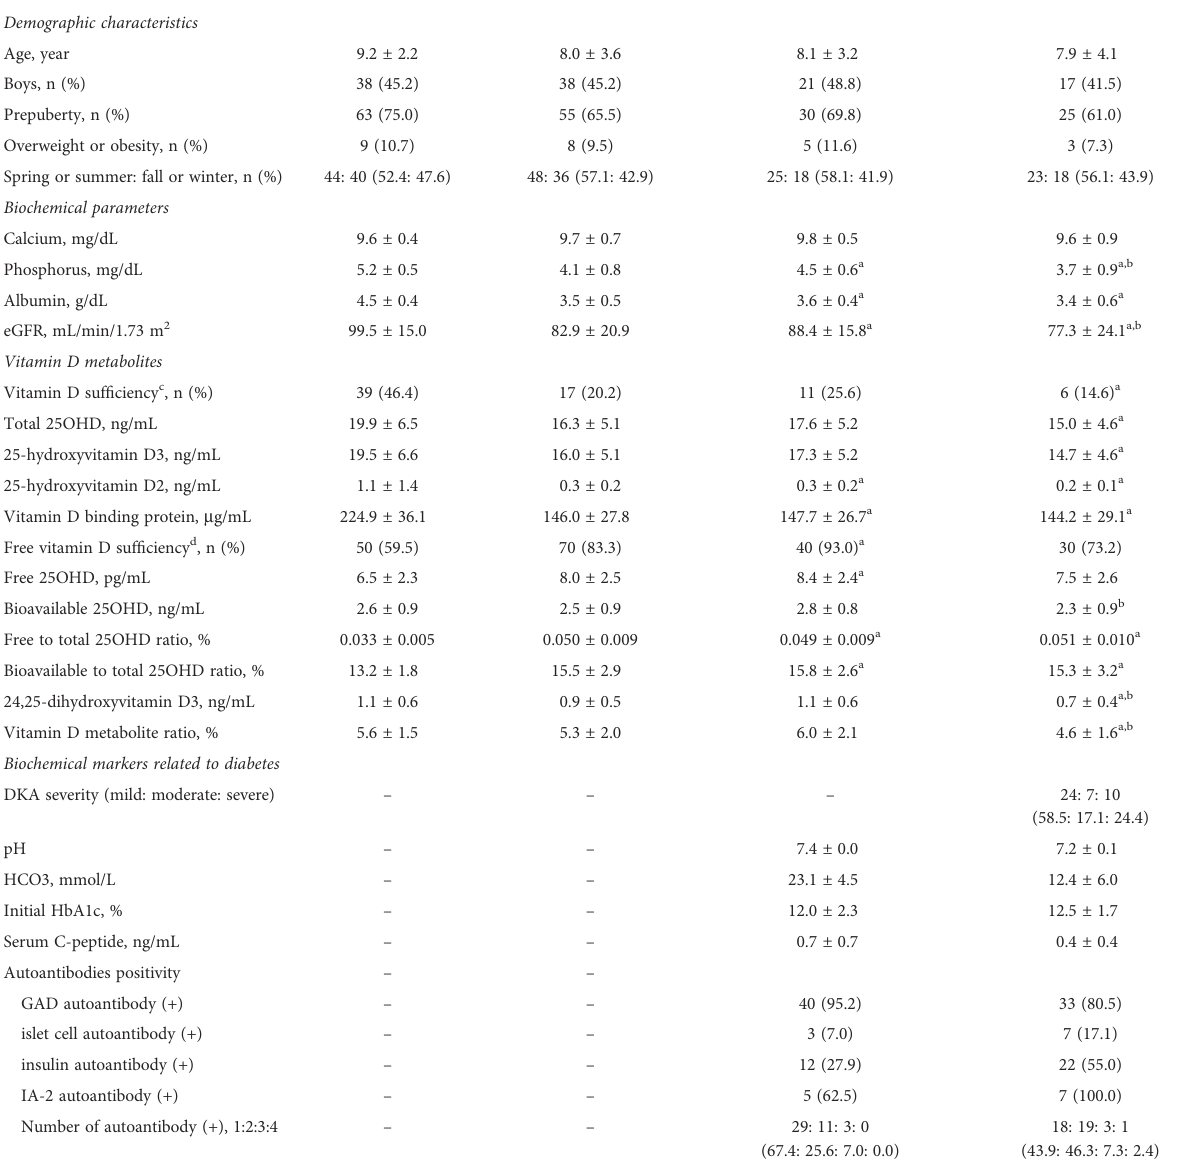
TABLE 1 Demographic characteristics and biochemical parameters between healthy control children and patients with type 1 diabetes, grouped by presence of diabetic ketoacidosis at